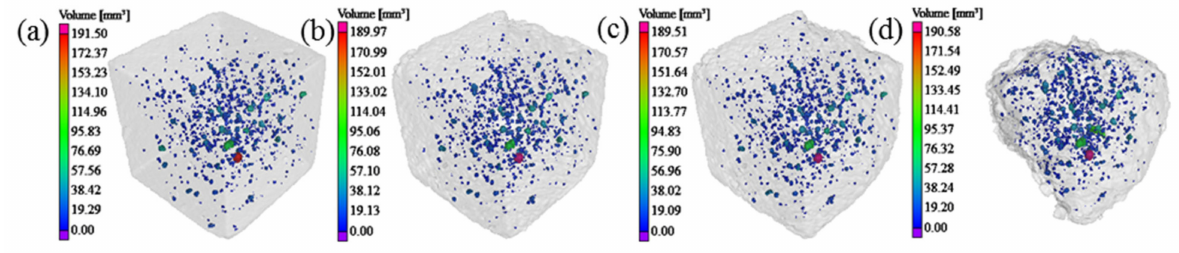
Figure 9. Pore structures in concrete: ( a ) 0; ( b ) 100; ( c ) 200; and ( d ) 300 salt freezing–thawing cycles.